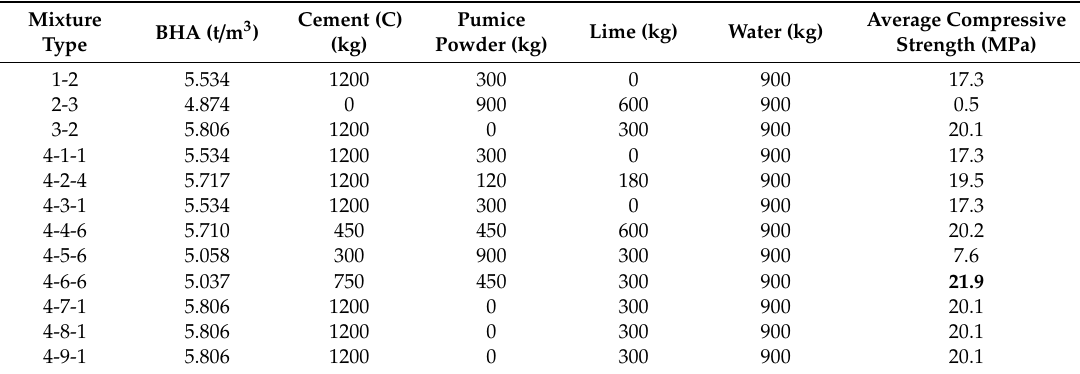
Table 34. Maximum compressive strength results for optimum binder fixation.